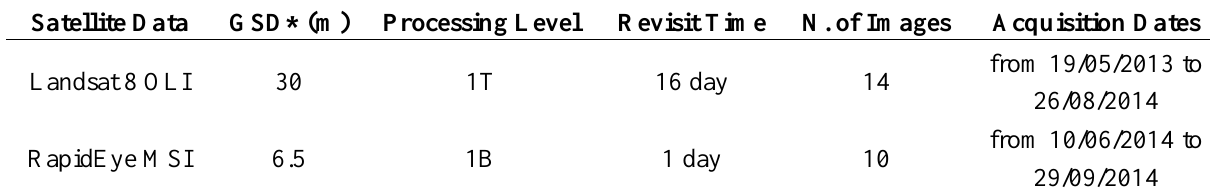
Table 1. Overview of the imagery dataset used in the study